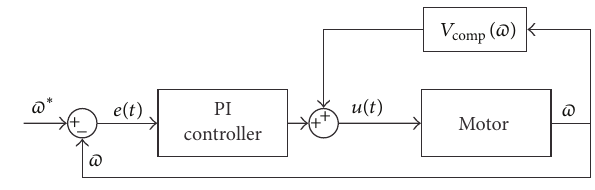
Figure 14: PI control strategy for a DC